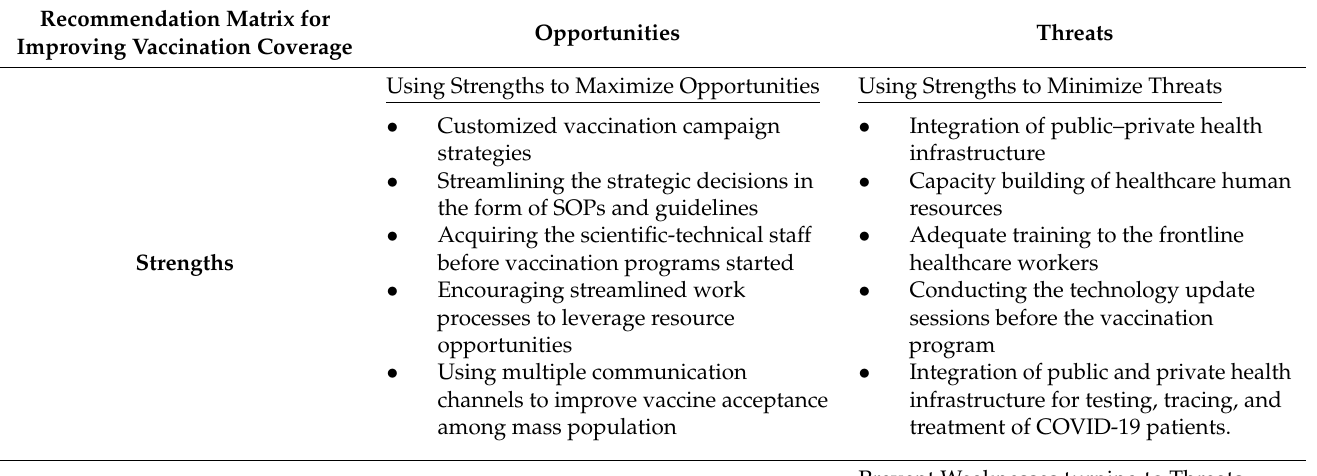
Table 8. SWOT analysis-based recommendation